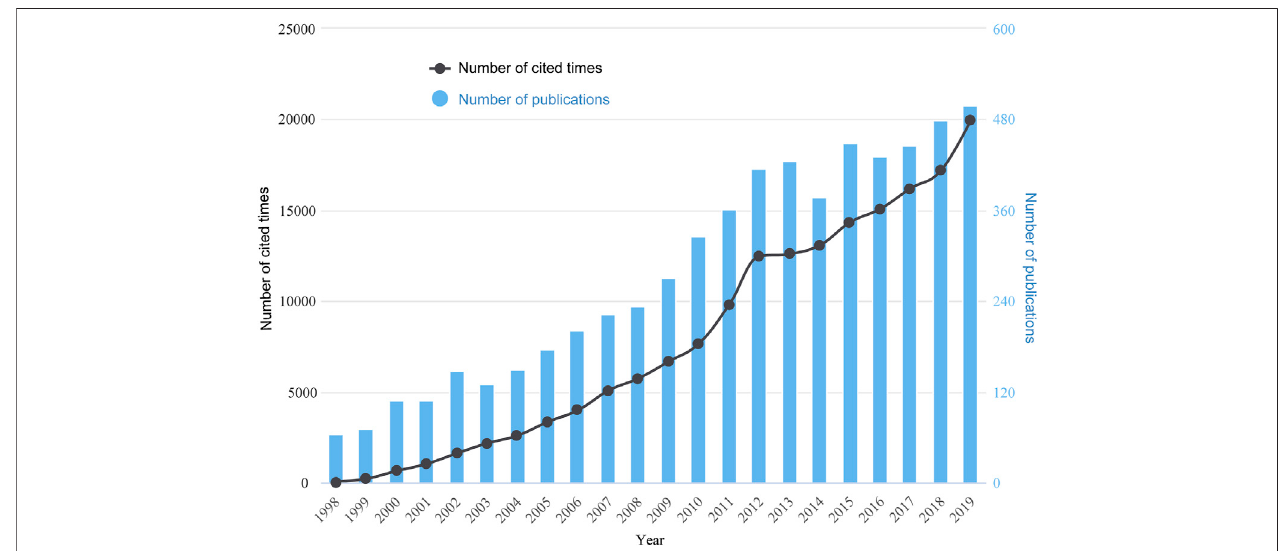
FIGURE 2 | Global trend of annual publications and citations related to ultrasound microbubble research from 1998 to 2019.